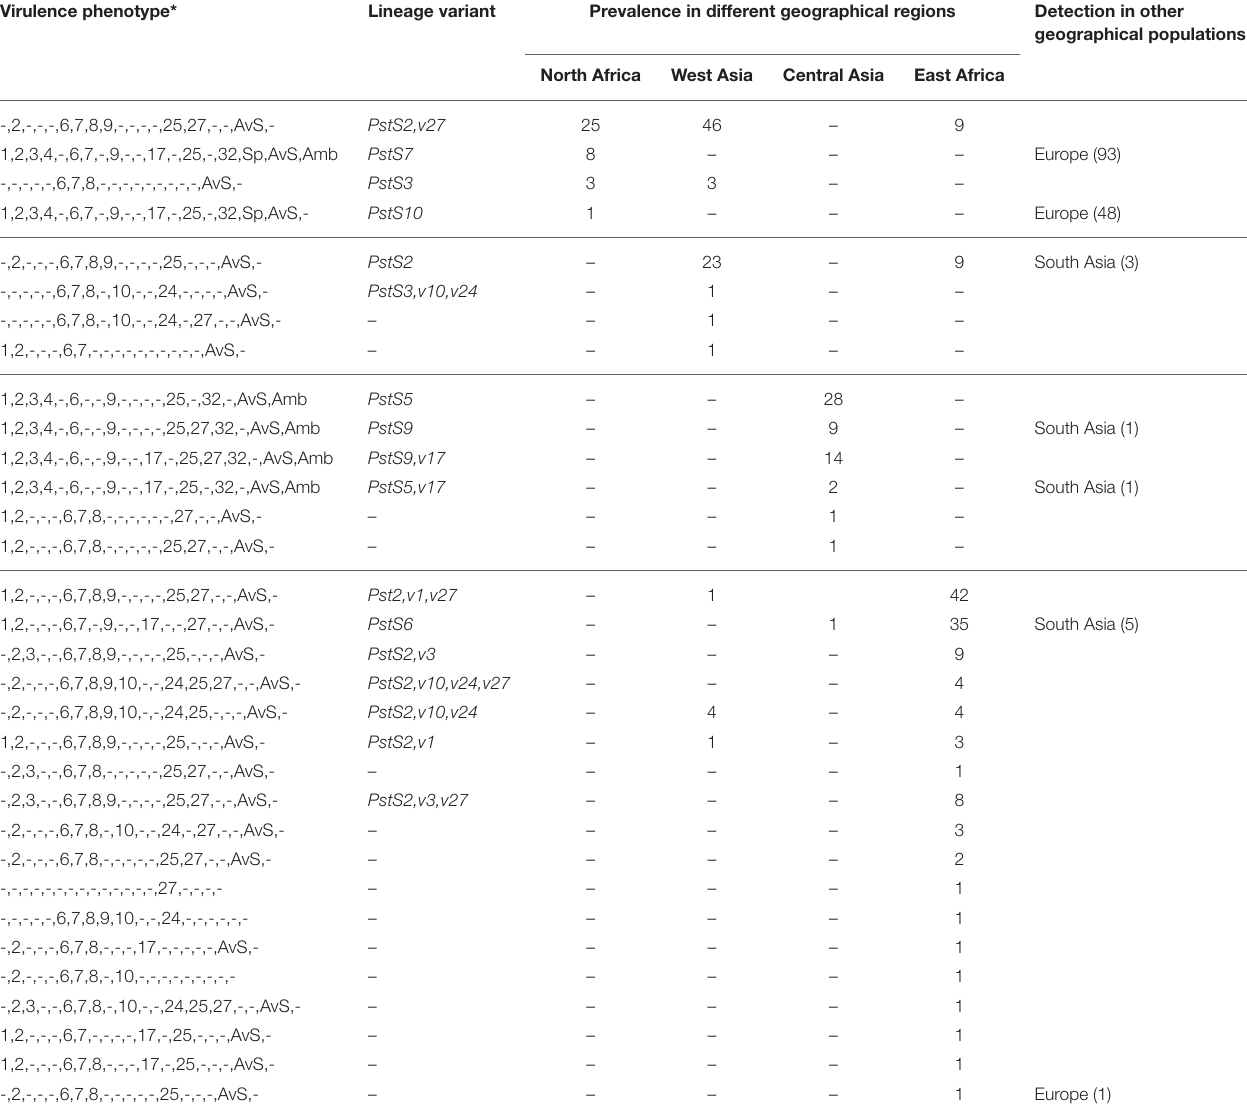
TABLE 4C | Prevalence of P. striiformis races detected in Central Asia, West Asia and East and North Africa during